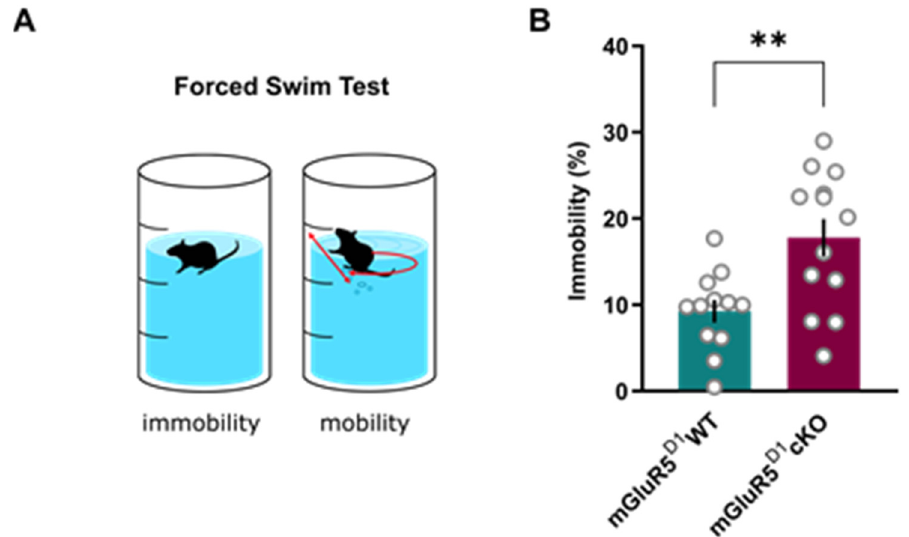
Figure 2. ( A ) Scheme of the forced swim test (FST). ( B ) Time spent immobile during the test (%). mGluR5 D1 cKO mice showed higher time spent immobile than their WT littermates. Unpaired T-test, T = 3.49, p = 0.002. n = 12 mGluR5 D1 WT, n = 13 mGluR5 D1 cKO mice. ** p ≤ 0.01.